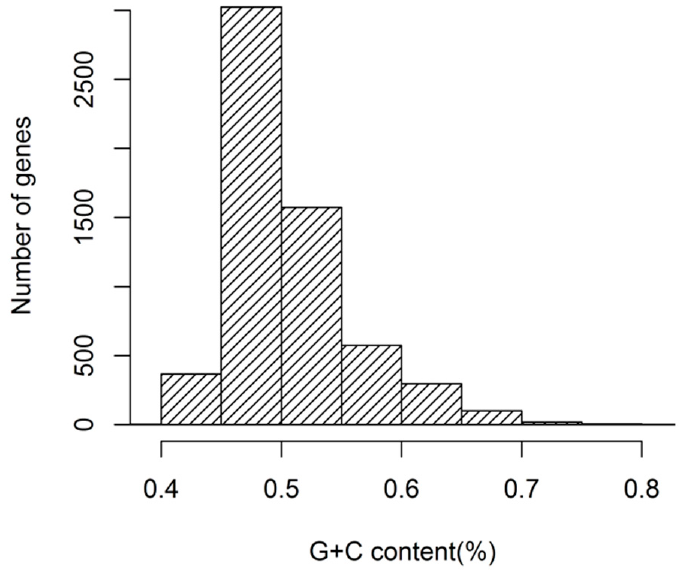
Figure 1. Distribution of GC contents in G. duodenalis genes. To study the relationship between the three codon positions, the neutrality graph (GC12 versus GC3) of the G. duodenalis gene was constructed. Our result demonstrated that the GC3s of G. duodenalis genes was widely distributed (26.17% to 99.32%), and there was a significant correlation between GC12 and GC3 (r = 0.283, p < 0.0001) (Figure 2), indicating that mutation might affect the codon preference in G. duodenalis genome.